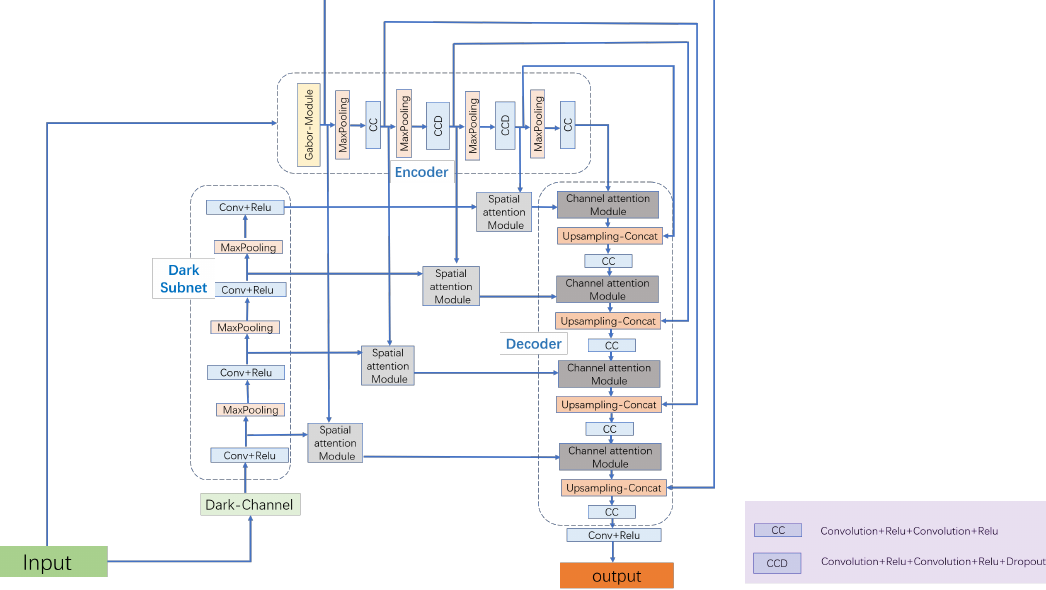
Figure 1. Block diagram of the Network based on the Gabor transform and Attention modules with Dark channel subnets (NGADs)